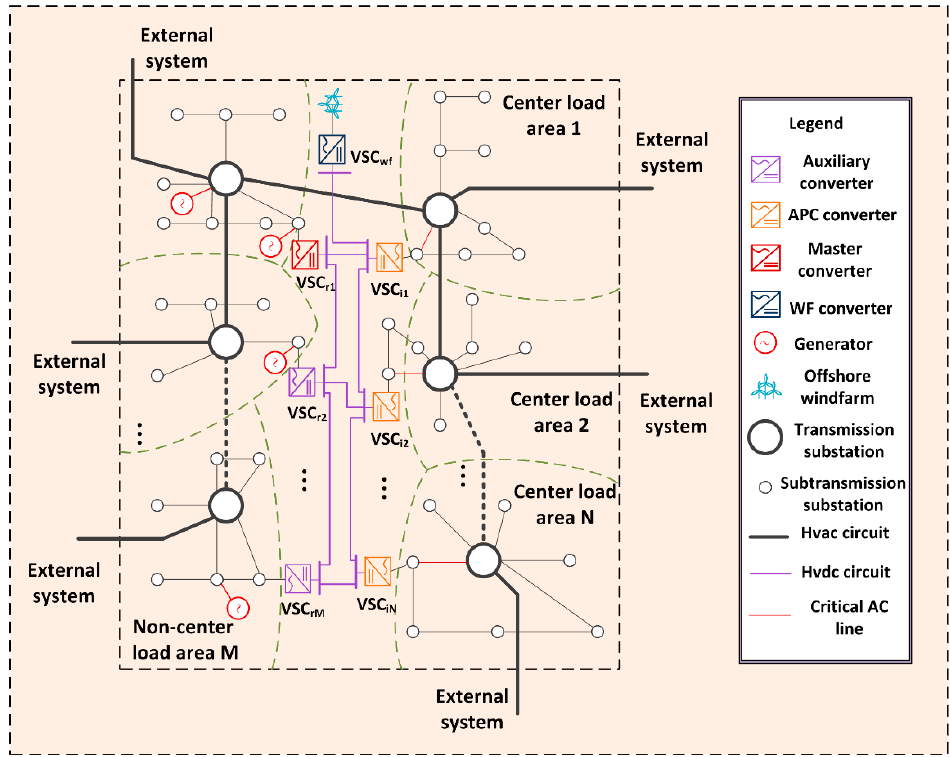
Figure 1. System structure of coastal urban multi-terminal DC (CU-MTDC).